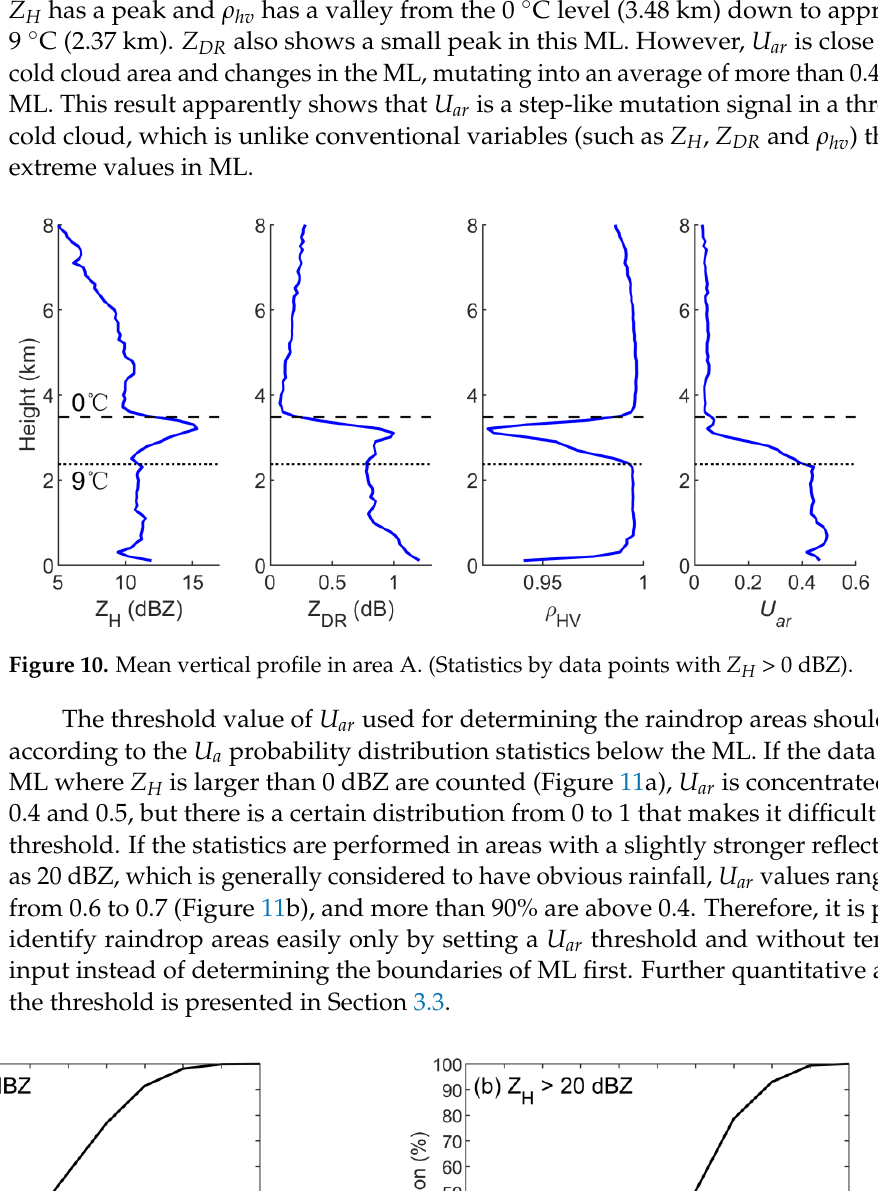
Figure 9. Sample RHI observations and retrievals of the convective system from the X-band dual polarization weather radar. (The time is 18:46:30 LST. The azimuth is the same as the dashed line in Figure 8b. The maximum elevation is 44°). ( a ) Z H , ( b ) Z DR , ( c ) ρ hv , ( d ) V R , ( f ) HC, ( e ) U ar .